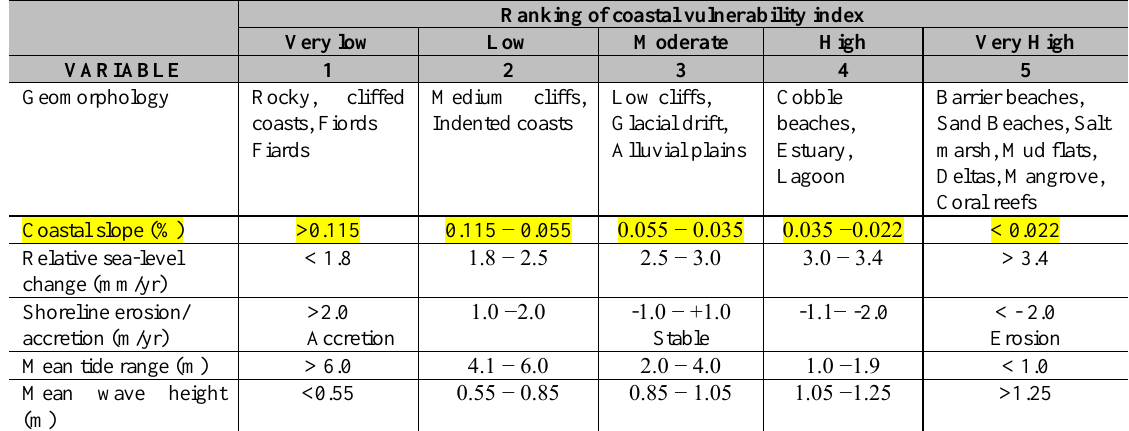
Table 1. Ranking of coastal vulnerability index variables for the U.S. Gulf of Mexico (Hammar-Klose and Thieler,